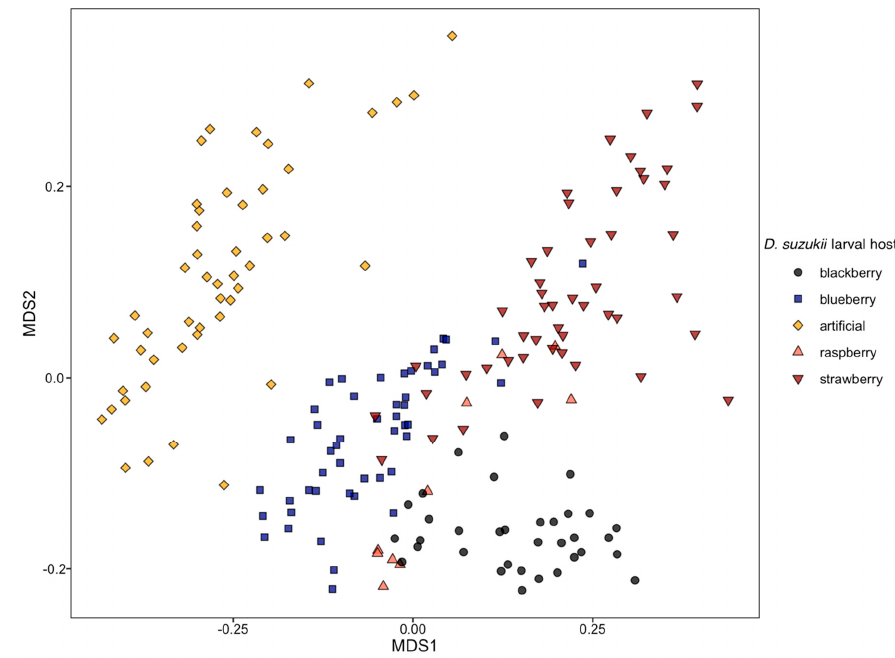
Figure 2. NMDS (2-dimensional) plot for proportion of fatty acids of Drosophila suzukii adults reared from di ff erent larval diets (Bray–Curtis dissimilarity index).